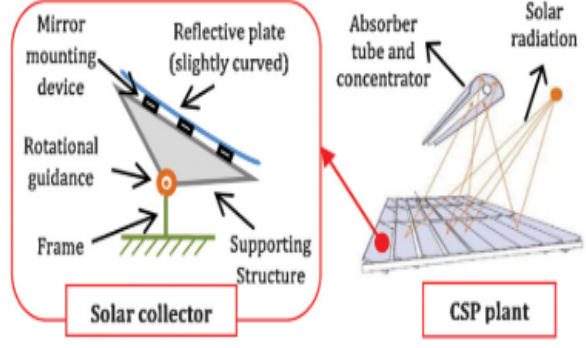
Figure 3. Schematization of solar